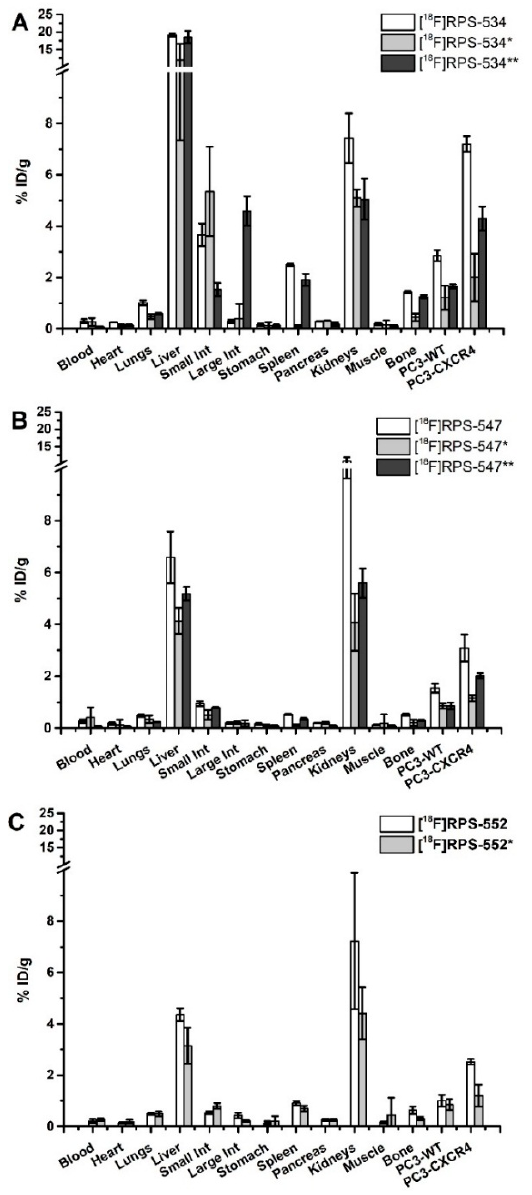
Figure 4. Biodistribution of ( A ) [ 18 F]RPS-534, ( B ) [ 18 F]RPS-547, and ( C ) [ 18 F]RPS-552 at 1 h p.i. and 2 h (**) p.i. in male BALB/C mice bearing bilateral PC3-WT/PC3-CXCR4 xenograft tumors. Blocking (*)